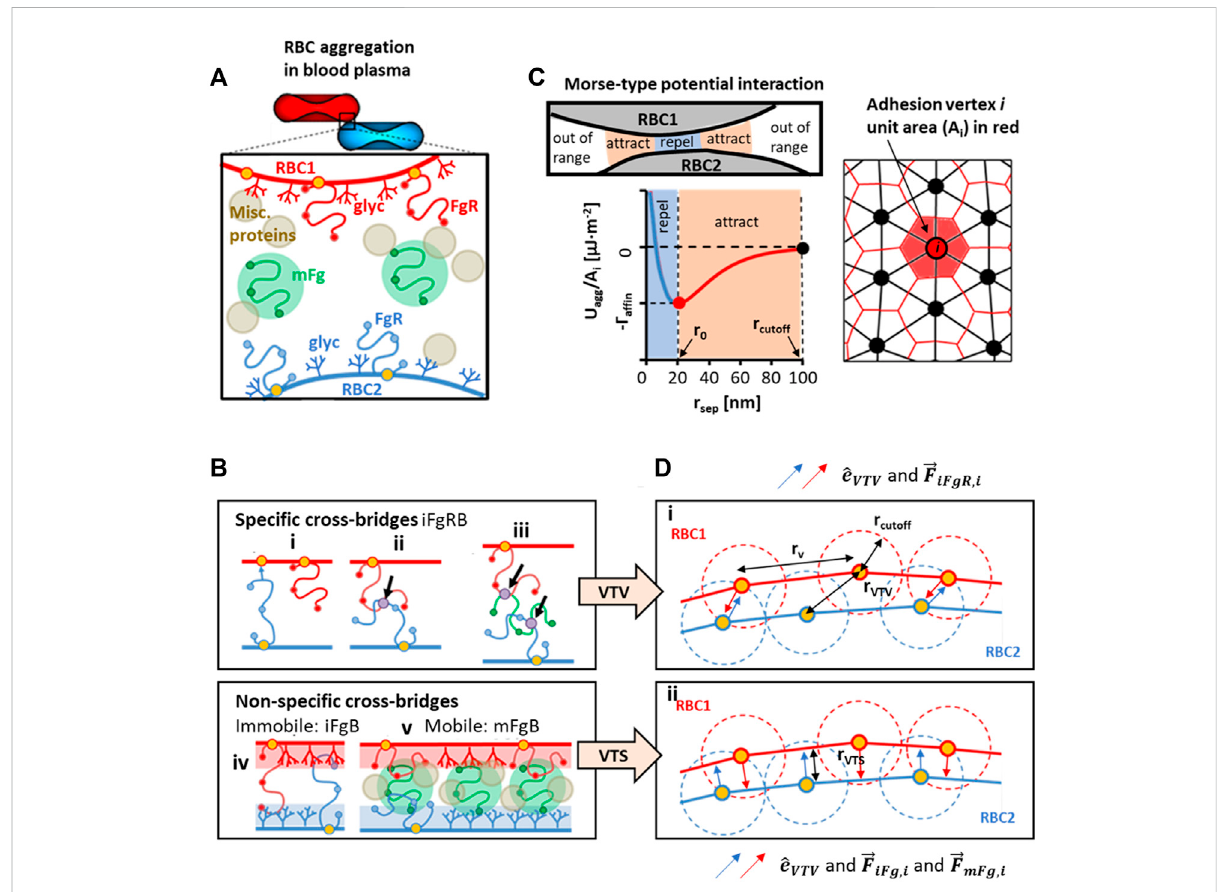
FIGURE 1 Conceptualization and modeled representation of cross-bridging possibilities in RBC aggregation. (A) Contributors to plasma-mediated RBC aggregationislikelytorequirecooperativitybetweenreceptor-boundFg(FgR),surfaceadsorbedFg(mFg)andotherplasmaproteinsandfactors. (B) Schematics of possible Fg to RBC surface interactions that can categorically be summarized into speci fi c cross-bridges (iFgRB) and non-speci fi c cross-bridges that are immobile (iFgB) and mobile (mFgB). (C) The Morse-type potential model used for calculating interaction energy at adhesion vertices and the median-dual area element around vertex i used to calculate local adhesion area (D) i)The speci fi c interaction scenarios in Ci,Cii,Ciiiarerepresentedbythevertex-to-vertex(VTV)scheme.ii)Thenon-speci fi cbridgingscenariosinCivandCvarerepresentedbythevertex- to-surface (VTS) scheme for distance and force